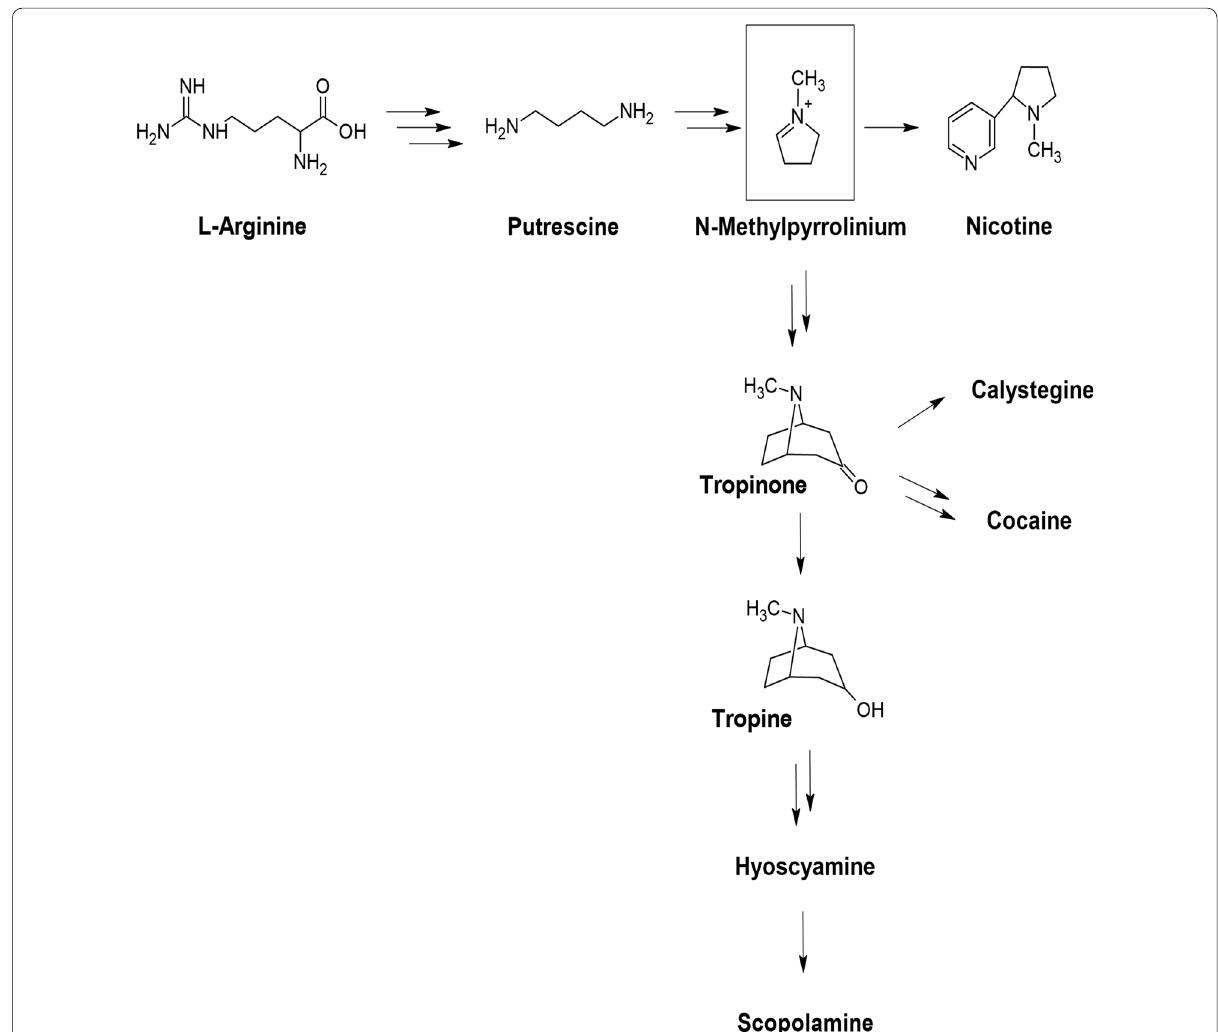
Fig. 3 Biosynthetic pathway of tropane